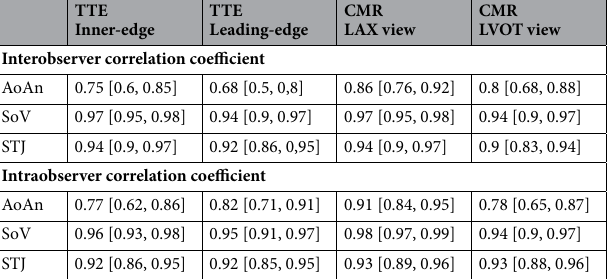
Table 3. Inter- and intraobserver variability of aortic root measured by transthoracic echocardiography and cardiac magnetic resonance imaging measured by intra-class correlation coefficient. ICC is presented as mean and 95%-confidence interval. Abbreviations as in Table 2.